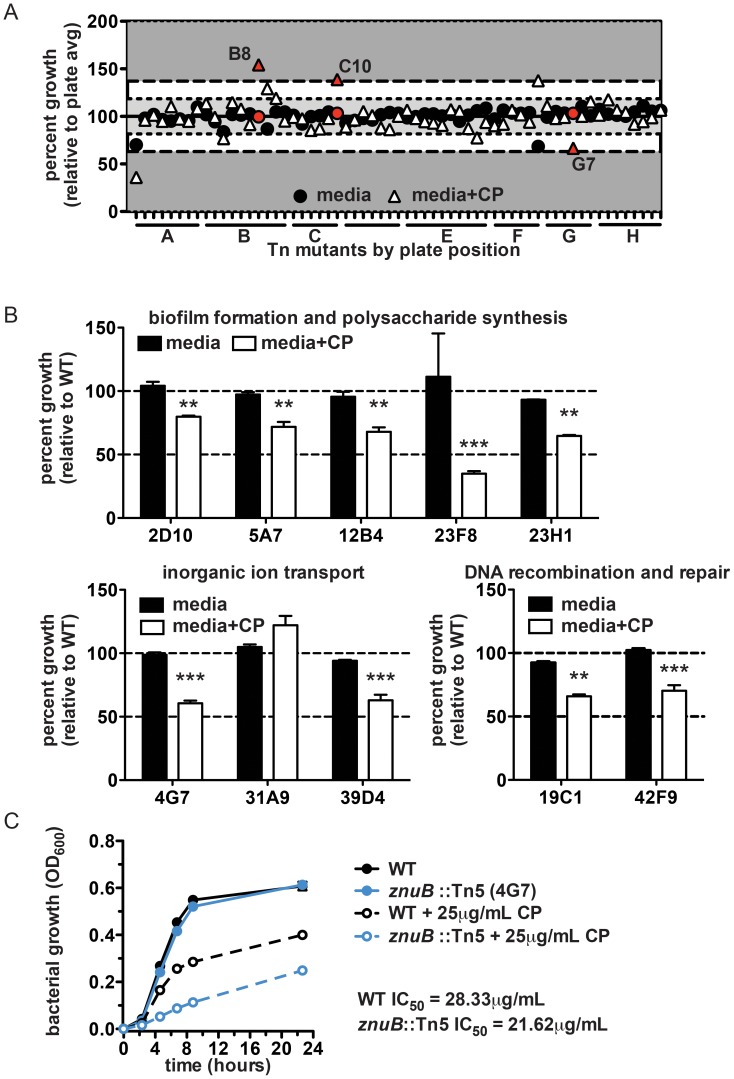
Transposon library screen to identify bacterial processes affected by CP treatment.(A) Bacterial growth from a representative plate of mutants cultured in media alone or media with 40 µg/ml CP. Data for wells in which no bacterial growth was observed in either condition have been omitted. Red symbols indicate mutants selected for secondary screening (see Materials and Methods). (B) Growth of selected mutants relative to wildtype bacteria cultured in media alone or media containing 40 µg/ml CP. Mutants are classified according to the predicted functional category of the gene disrupted by the transposon. ** p<0.01, *** p<0.001 for relative growth in the presence of CP compared to media alone, as determined by two-way ANOVA. (C) Growth curves comparing wildtype A. baumannii and znuB::Tn5 in the presence or absence of 25 µg/ml CP. IC50 values were determined as described in the Materials and Methods.